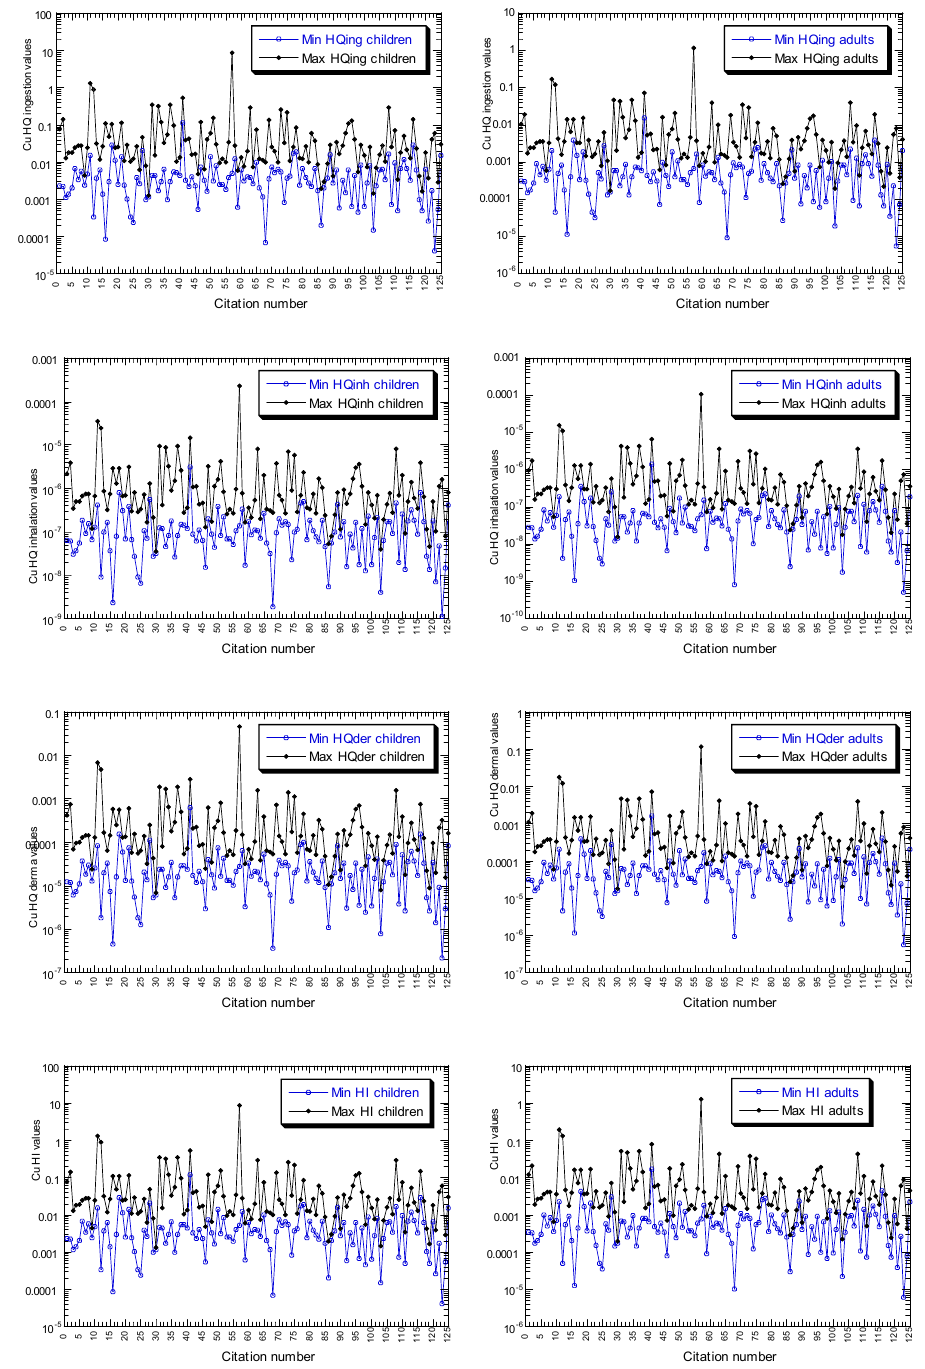
Figure 4. The values of hazard quotient ingestion (HQ ing ), hazard quotient inhalation (HQ inh ), hazard quotient dermal contact (HQ der ), and hazard index (HI) for adults and children based on the Cu data ranges (minimum and maximum) in the sediments cited from 125 papers in the literature published between 1980 and 2022. The citation numbers follow the detailed reference numbers presented in Tables S1 and S2.